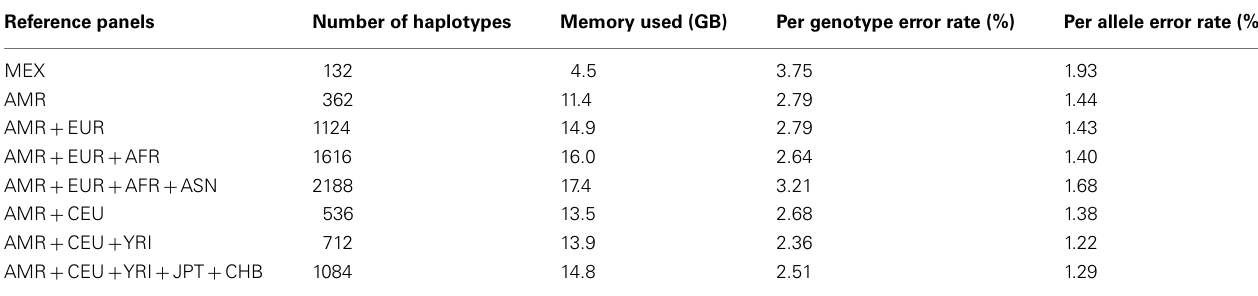
TableA1 | Genotype imputation accuracy for chromosome 9 based on the 1000 Genomes Project reference panels.